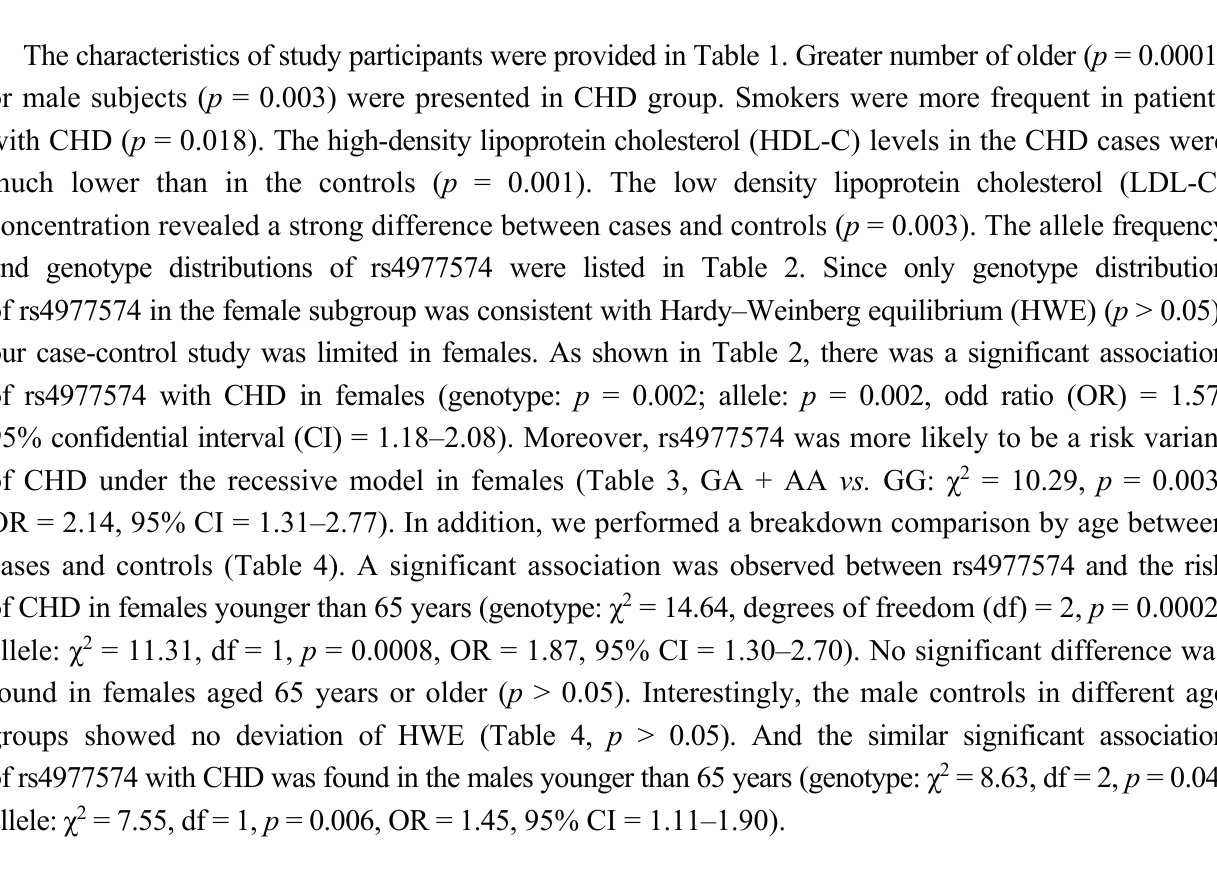
Table 1. Epidemiological characteristics in Coronary heart disease (CHD) cases and